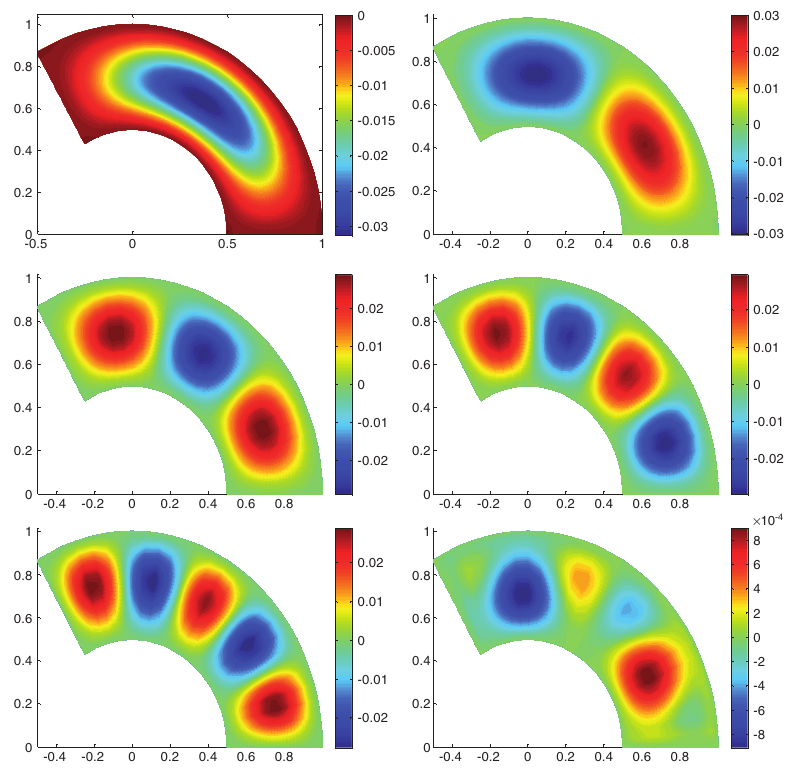
Figure 4 The first six mode shapes of a fully clamped isotropic FG annular sector plate for n = 1 and θ = 120 ° .